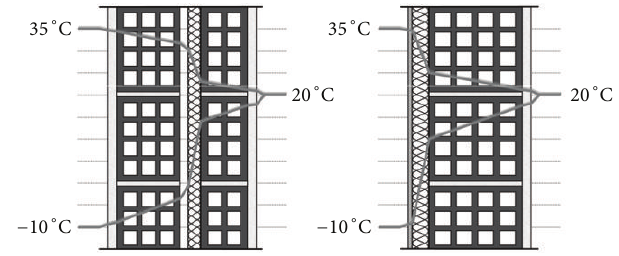
Figure 3: Temperature variation in exterior walls